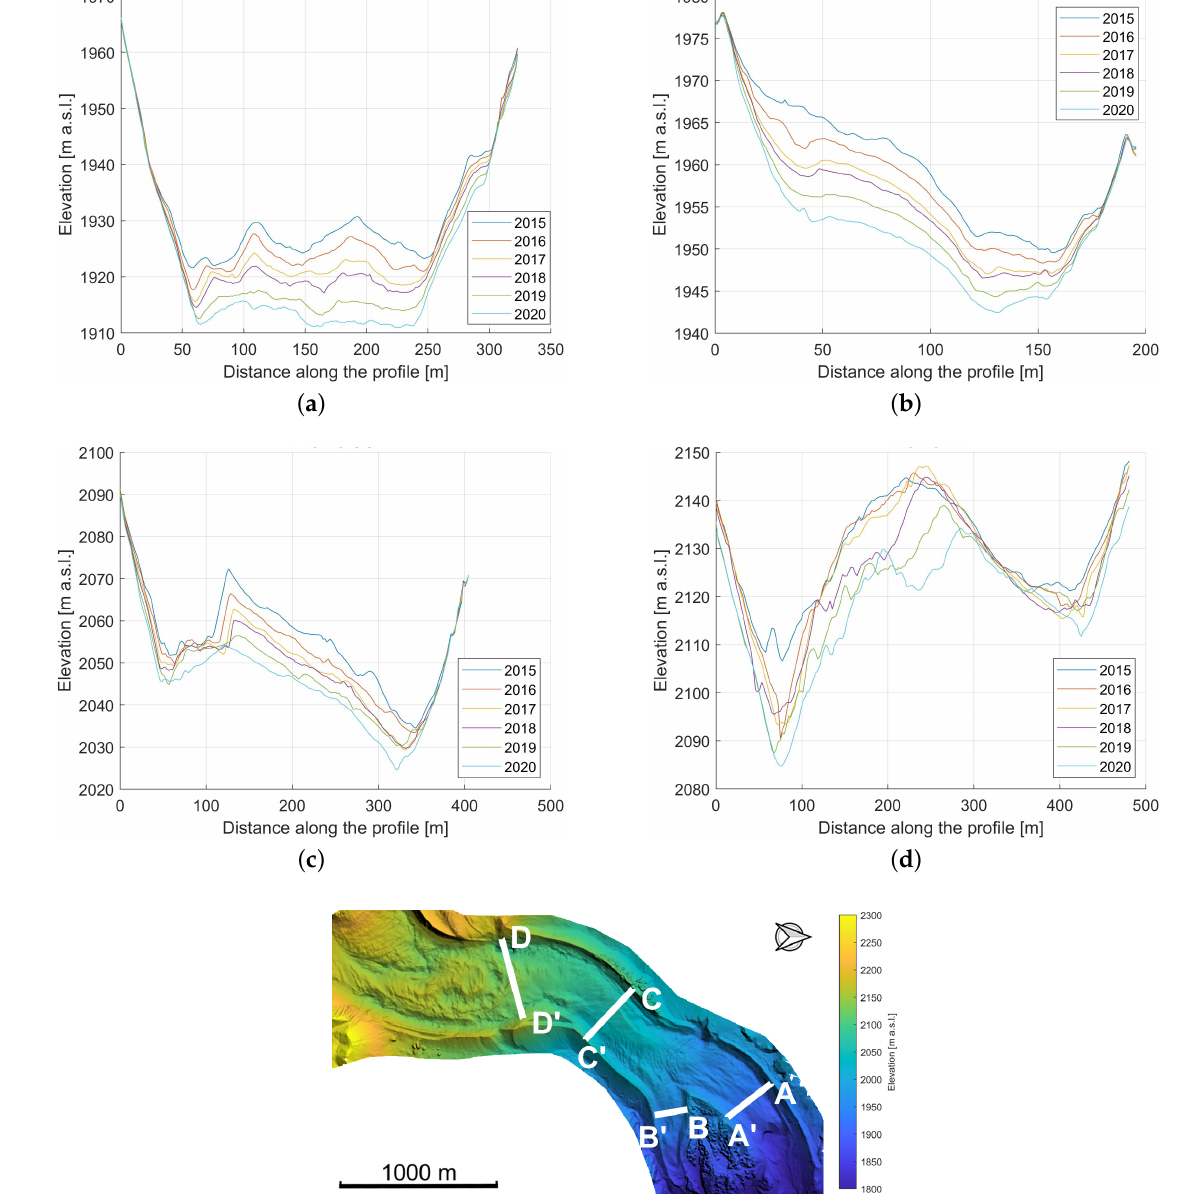
Figure 10. Elevation profiles obtained from the DSM computed on the years 2015–2020 along 4 different cross-sections. ( a ) Cross-section AA’ at the north-west glacier tongue; ( b ) Cross-section BB’ at the south toungue; ( c ) Cross-section CC’ in the lower portion of the glacier transition sector; ( d ) Cross-section DD’ in the upper portion of the glacier transition sector; ( e ) Cross-sections location. Cross-sections are seen from South towards North (i.e., from upstream to downstream of the glacier), as marked by the letters in ( e